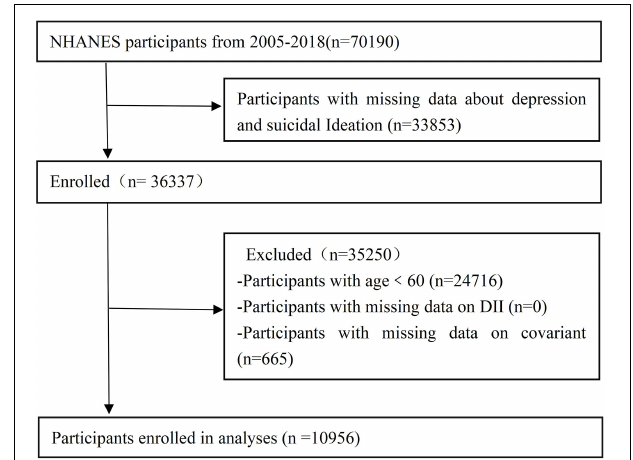
FIGURE 1 | Flow diagram of the screening and selection